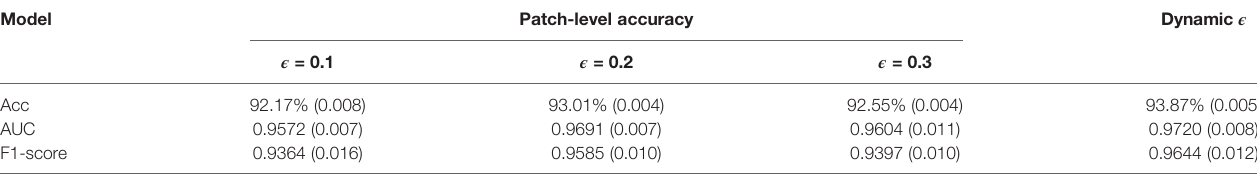
TABLE 2 | Patch-level accuracy with label smoothing of different weight ϵ , which was trained on the screened dataset of ×20 magni fi cation and evaluated on a validating set.